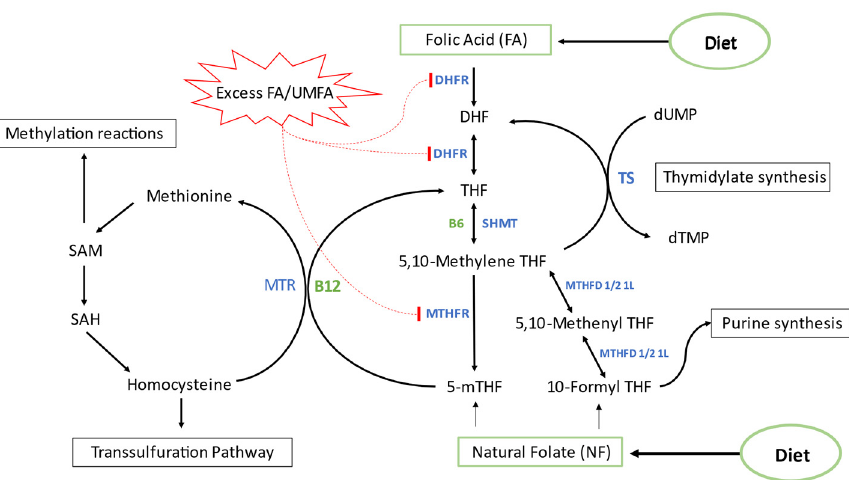
Figure 1. One carbon folate metabolism. Abbreviations: FA = Folic acid, NF = Natural Folate, UMFA = unmetabolized folic acid, DHFR = Dihydrofolate reductase, DHF = Dihydrofolate, THF = Tetrahydrofolate, SHMT = Serine hydroxymethyltransferase, TS = Thymidylate synthase, MTHFR = Methylenetetrahydrofolate reductase, MTHFD = Methylenetetrahydrofolate dehydrogenase, MTR = 5-Methyltetrahydrofolate-Homocysteine Methyltransferase or Methionine synthase, SAM = S-adenosyl-methionine, SAH = S-adenosyl-homocysteine.